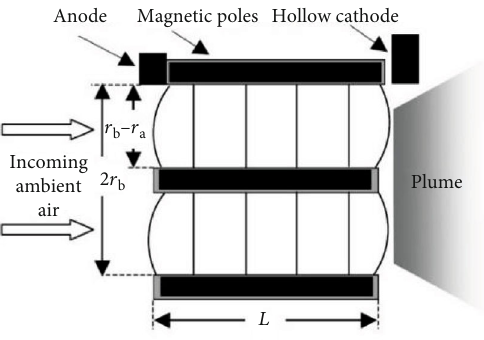
Figure 15: Schematic of atmosphere-breathing Hall thruster (not to scale) [45].